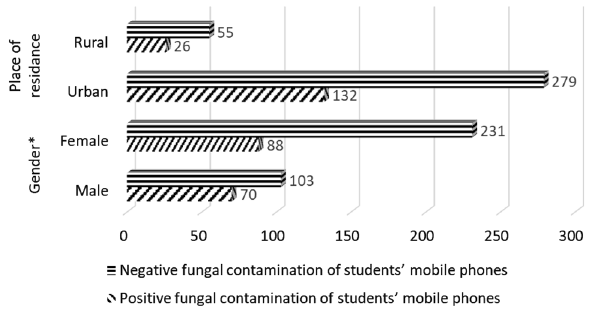
Figure 1. Distribution of demographic characteristics in 492 medical students by presence of fungal contamination of students’ mobile phones; *the significant difference between two observed